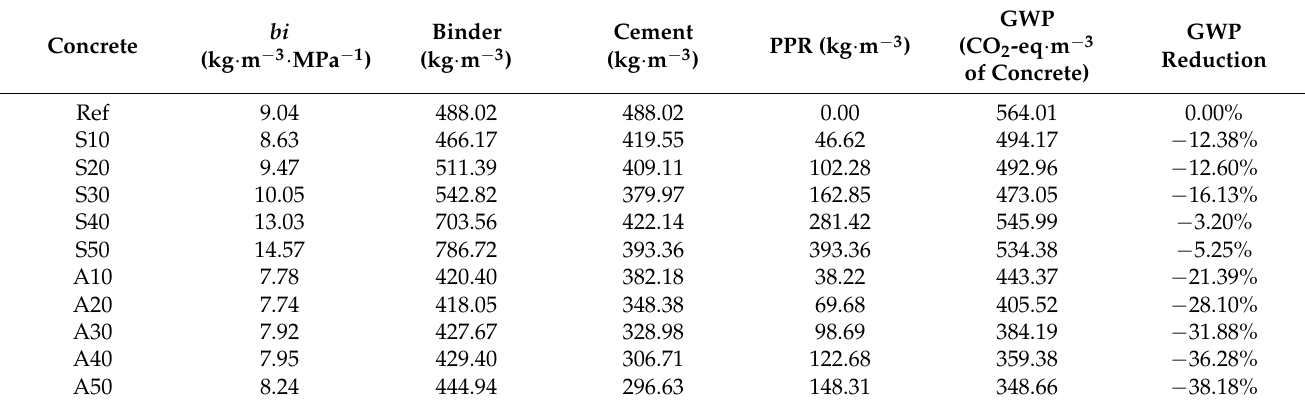
Table 4. Global warming potential